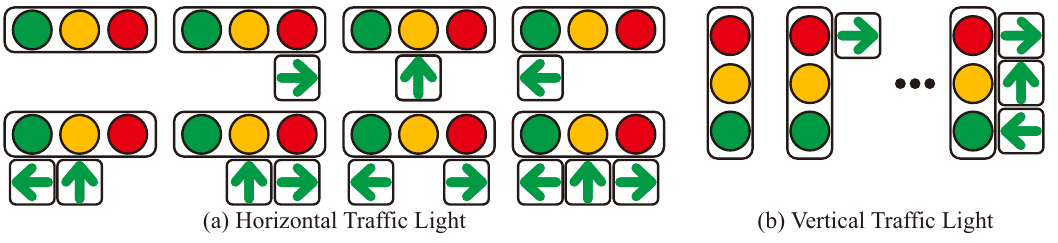
Figure 2. Traffic light patterns that can be recognized in the proposed